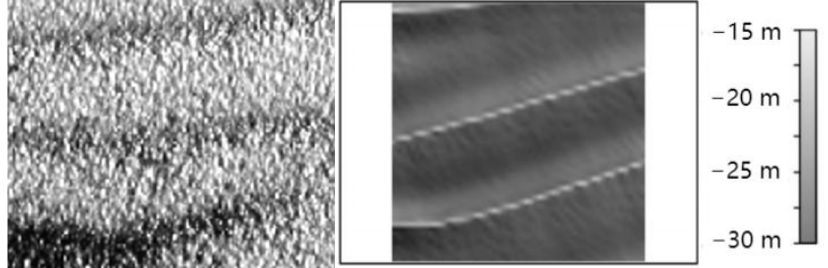
Figure 6. Original content image of area a ( left ) and water depth inversion image ( right ).